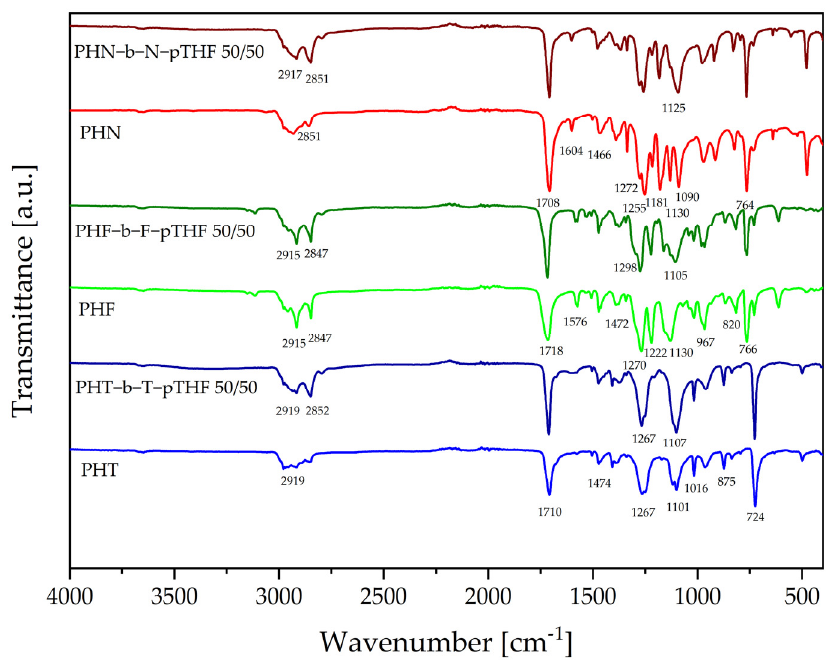
Figure 6. FTIR spectra of the synthesized materials.